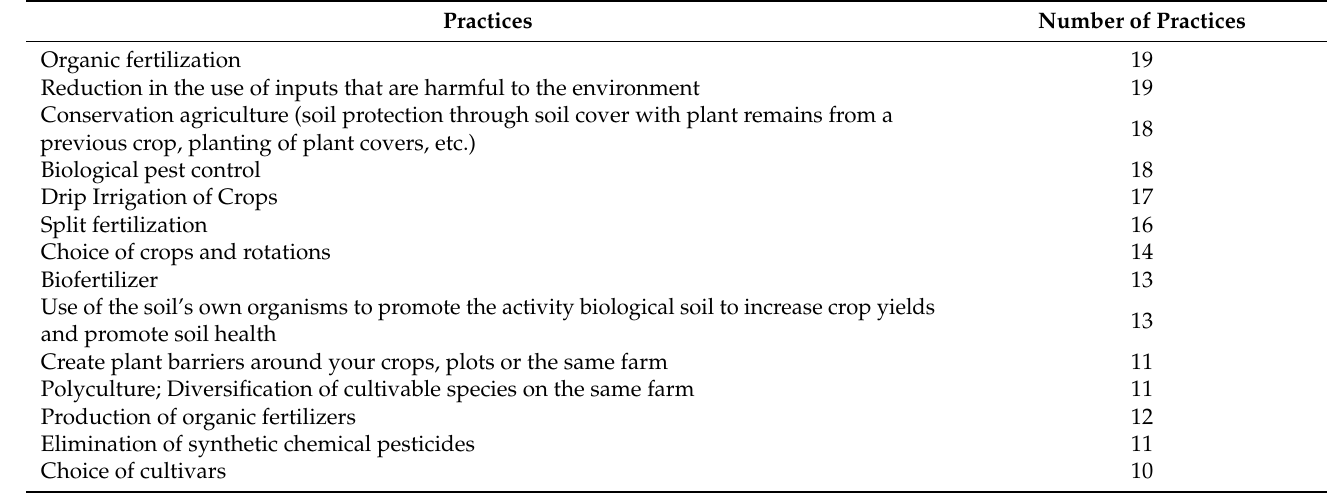
Table 2. Number of farmers who have chosen each practice and number of practices who have chosen each of the farmers. Practices Number of Practices Organic fertilization 19